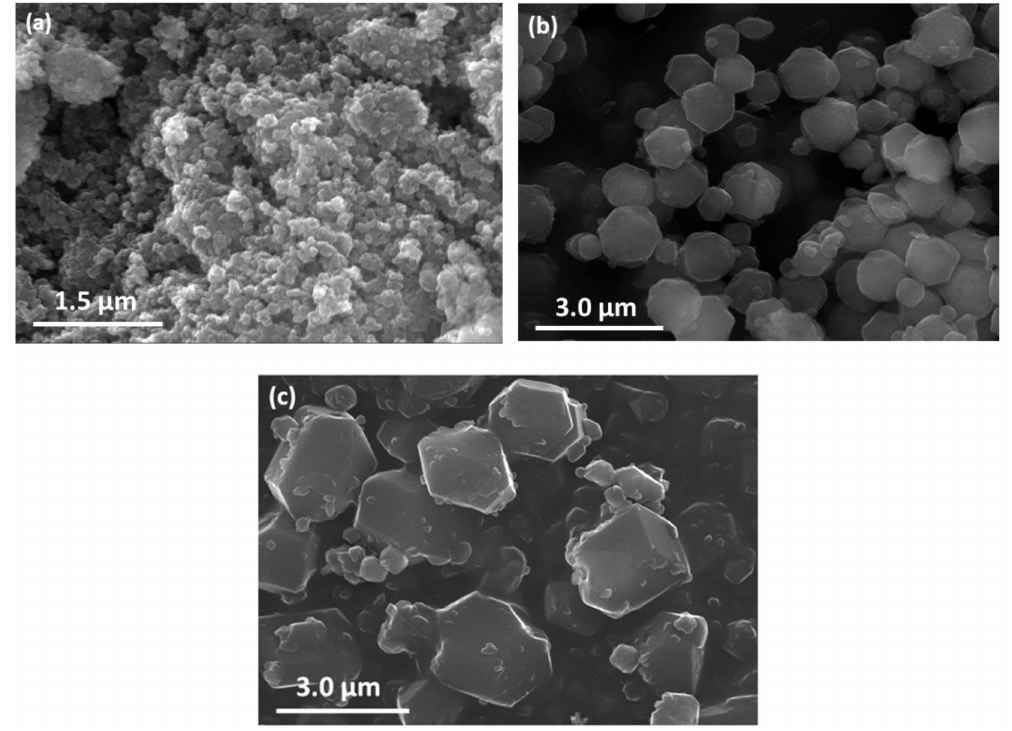
Figure 2. SEM images of ( a ) ZIF-8A, ( b ) ZIF-8B, and ( c )